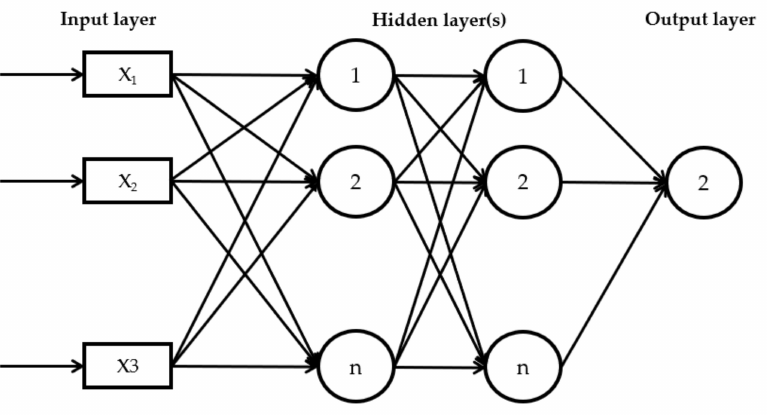
Figure 2. The schematic diagram of an artificial neural network, with n represents the number of layers and X represents the input